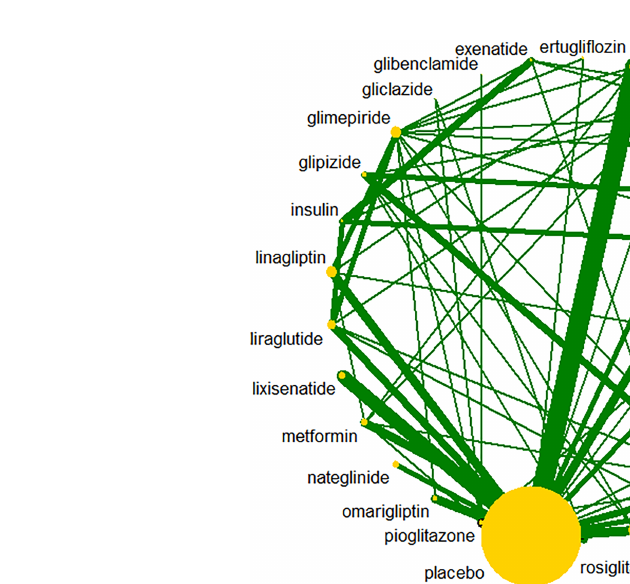
sitagliptin versus glimepiride, empagli fl ozin versus linagliptin, omarigliptin versus glimepiride, ertugli fl ozin versus glimepiride, dulaglutide versus metformin, omarigliptin versus glibenclamide,